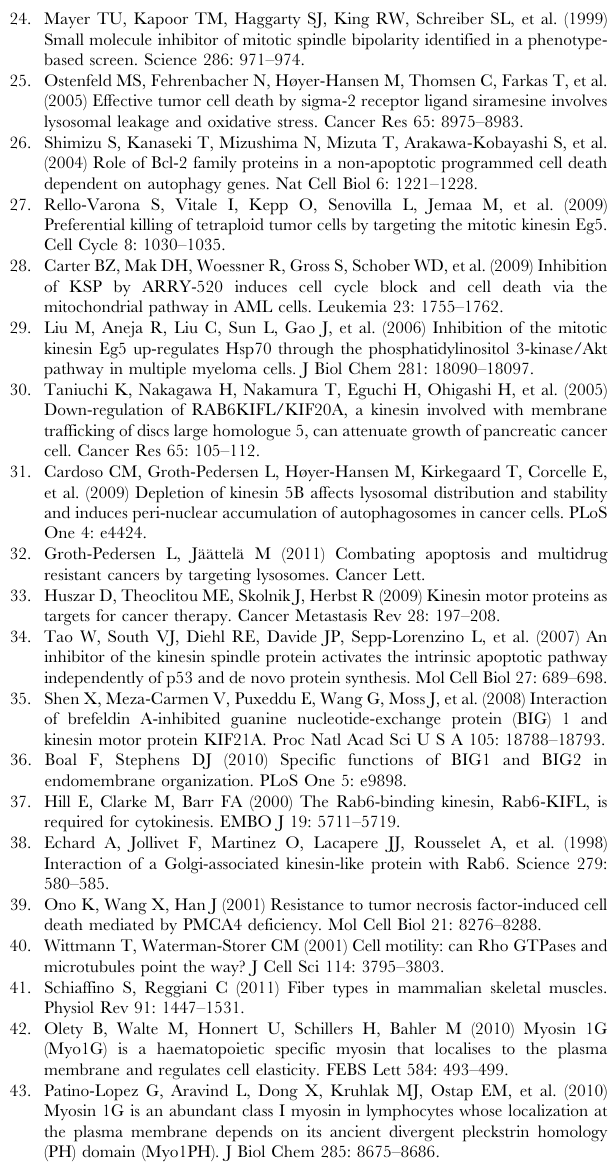
Table S1 Overview of Silencer H Molecular Motor Li- brary.